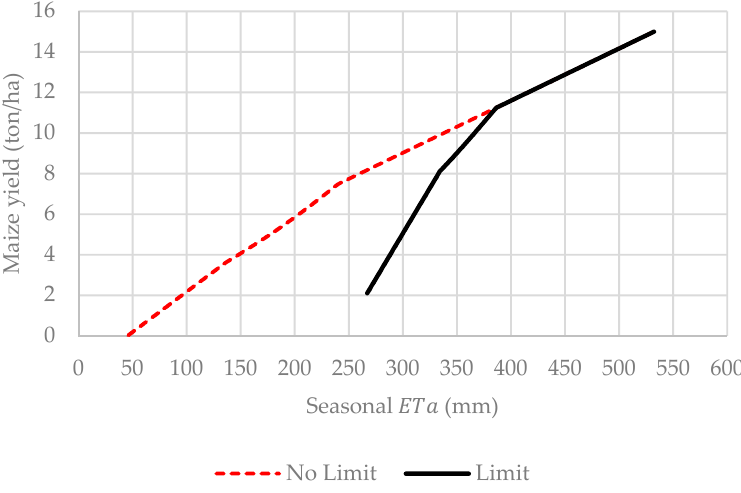
Figure 5. Maize yield as a function of actual evapotranspiration ( ETa ) for a no stage specific stress limit (No Limit) and a 50% stage specific limit on evapotranspiration deficits (Limit) using the Stewart multiplicative